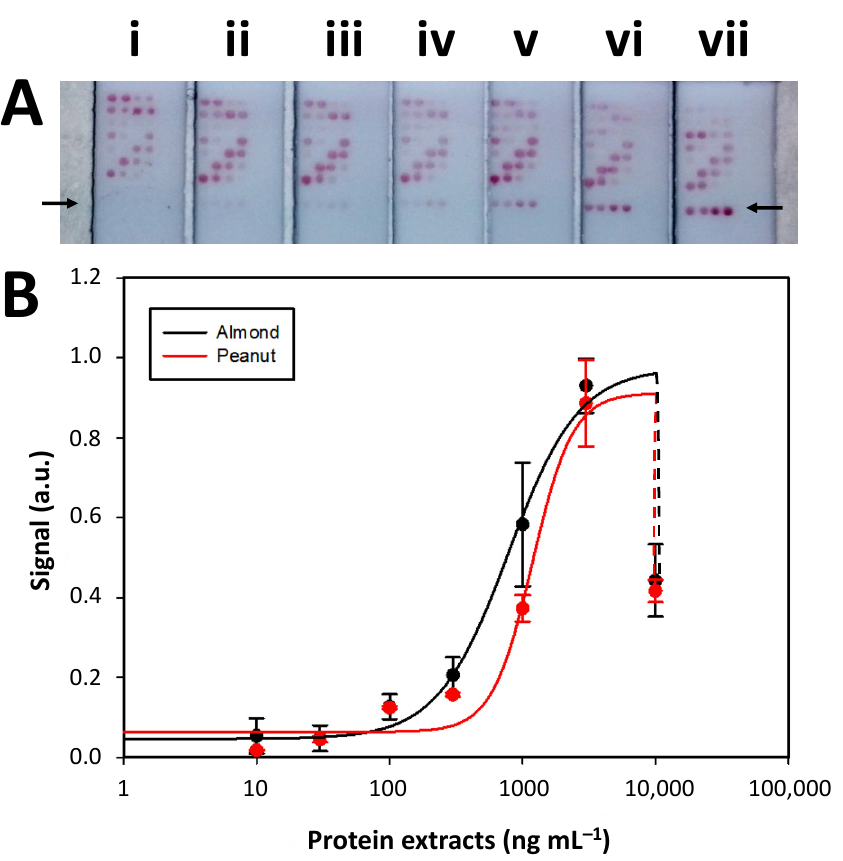
Figure 3. ( A ) Picture of the LFµIA strips after simultaneously detecting (i) 0, (ii) 10, (iii) 30, (iv) 100, (v) 300, (vi) 1000, and (vii) 3000 ng mL − 1 of almond- and peanut-extracted proteins. ( B ) Normalized (min–max) calibration curves obtained when quantifying the mean signal generated in test zone 1 (row R1). Error bars show the standard deviation of 3 replicates.